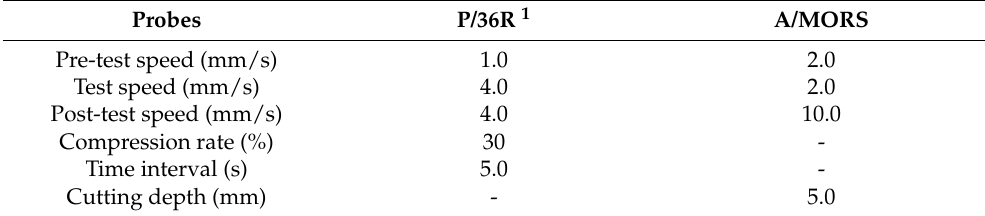
Table 1. Parameters for the instruments used to measure the textural properties of the cooled chicken drumsticks. Probes P/36R 1 Pre-test speed